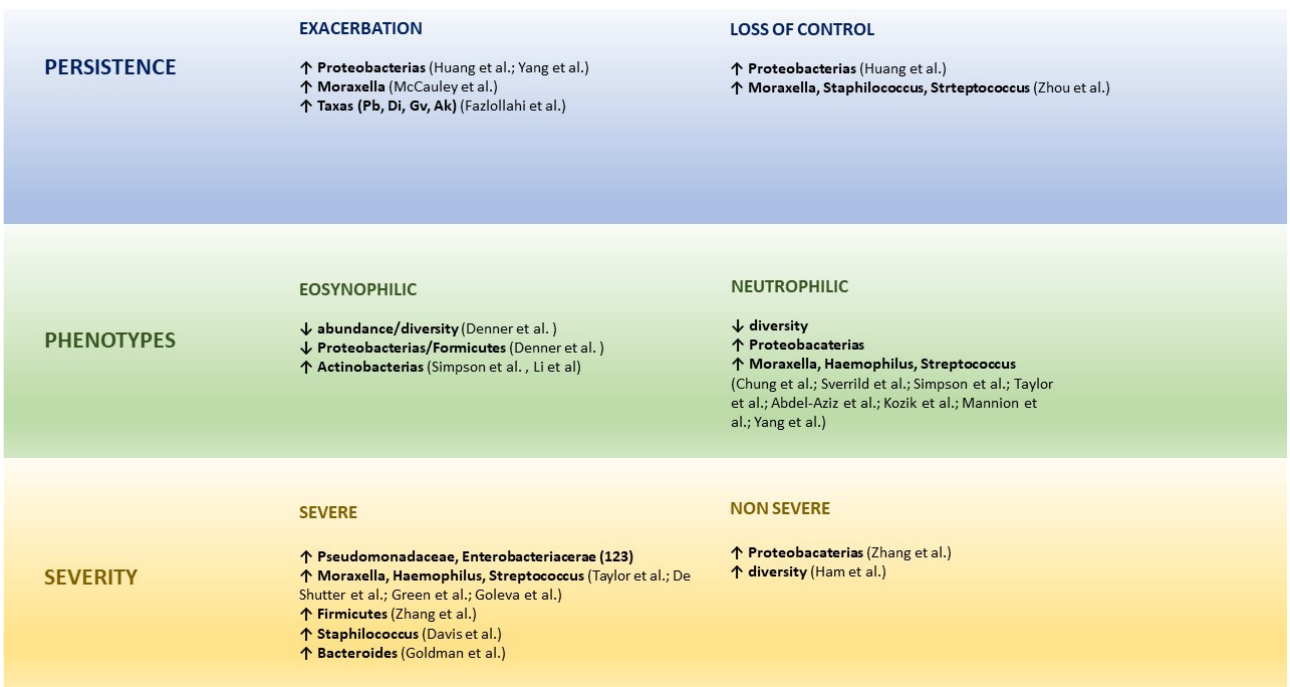
Figure 4. Main studies on intestinal or respiratory microbiome and asthma in children, adolescent and adult patients. Pb: Prevotella buccalis ; Di: Dialister invisus ; Gv: Gardnerella vaginalis ; Ak: Alkanindiges hongkongensis. Abdel-Aziz et al. [118]; Chung et al. [54]; Davis et al. [99]; De Shutter et al. [124]; Denner et al. [114]; Fazlollahi [106]; Goldman et al. [129]; Goleva et al. [127]; Green et al. [125]; Ham et al. [132]; Huang et al. [104]; Kozik et al. [120]; Li et al. [123]; Mannion et al. [121]; McCauley [107]; Simpson et al. [119]; Sverrild et al. [110]; Taylor et al. [113]; Yang et al. [105]; Yang et al. [122]; Zhang et al. [102]; Zhou et al. [101].